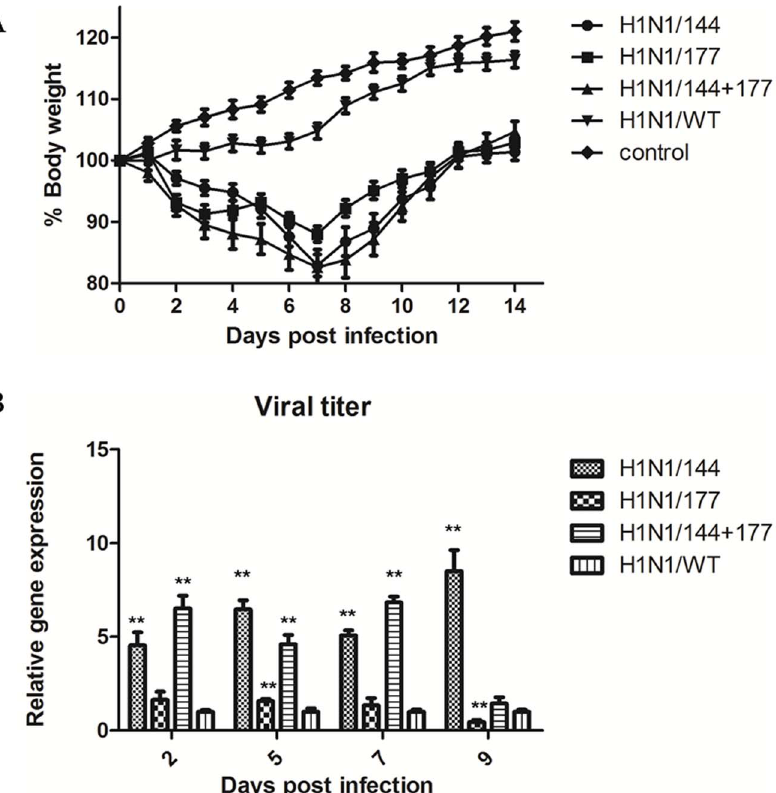
Figure 4. Weight loss and lung virus titres in infected mice. (A) Weight loss of mice inoculated with strains having different N-glycosylation sites on HA. Six-week-old BALB/c mice were inoculated intranasal with 10 3 50% egg infectious dose (EID 50 ) of the recombinant influenza viruses, with 8 mice per group. P , 0.05 between H1N1/144 + 177 and H1N1/WT on 3, 4 days post infection, P , 0.01 between H1N1/144 + 177 and H1N1/WT on 5 days post infection, P , 0.05 between H1N1/177 and H1N1/WT on 3–12 days post infection, P , 0.01 between H1N1/177 and H1N1/WT on 13, 14 days post infection, P , 0.01 between H1N1/144 or H1N1/144 + 177 and H1N1/WT on 6–14 days post infection. (B) Viral titres in lung of infected mice were indicated by the expression of NP gene. The statistical analysis was performed using Student’s t test. *, P , 0.05; **, P , 0.01 between the recombinant mutants and H1N1/WT viral titer.